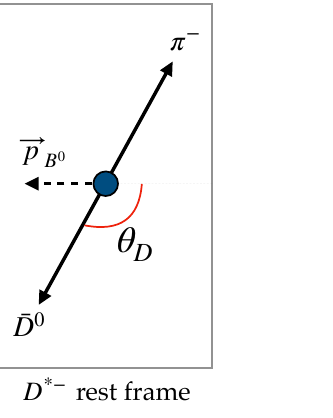
Figure 1 . Illustration of the B 0 → D ∗− D ∗ +